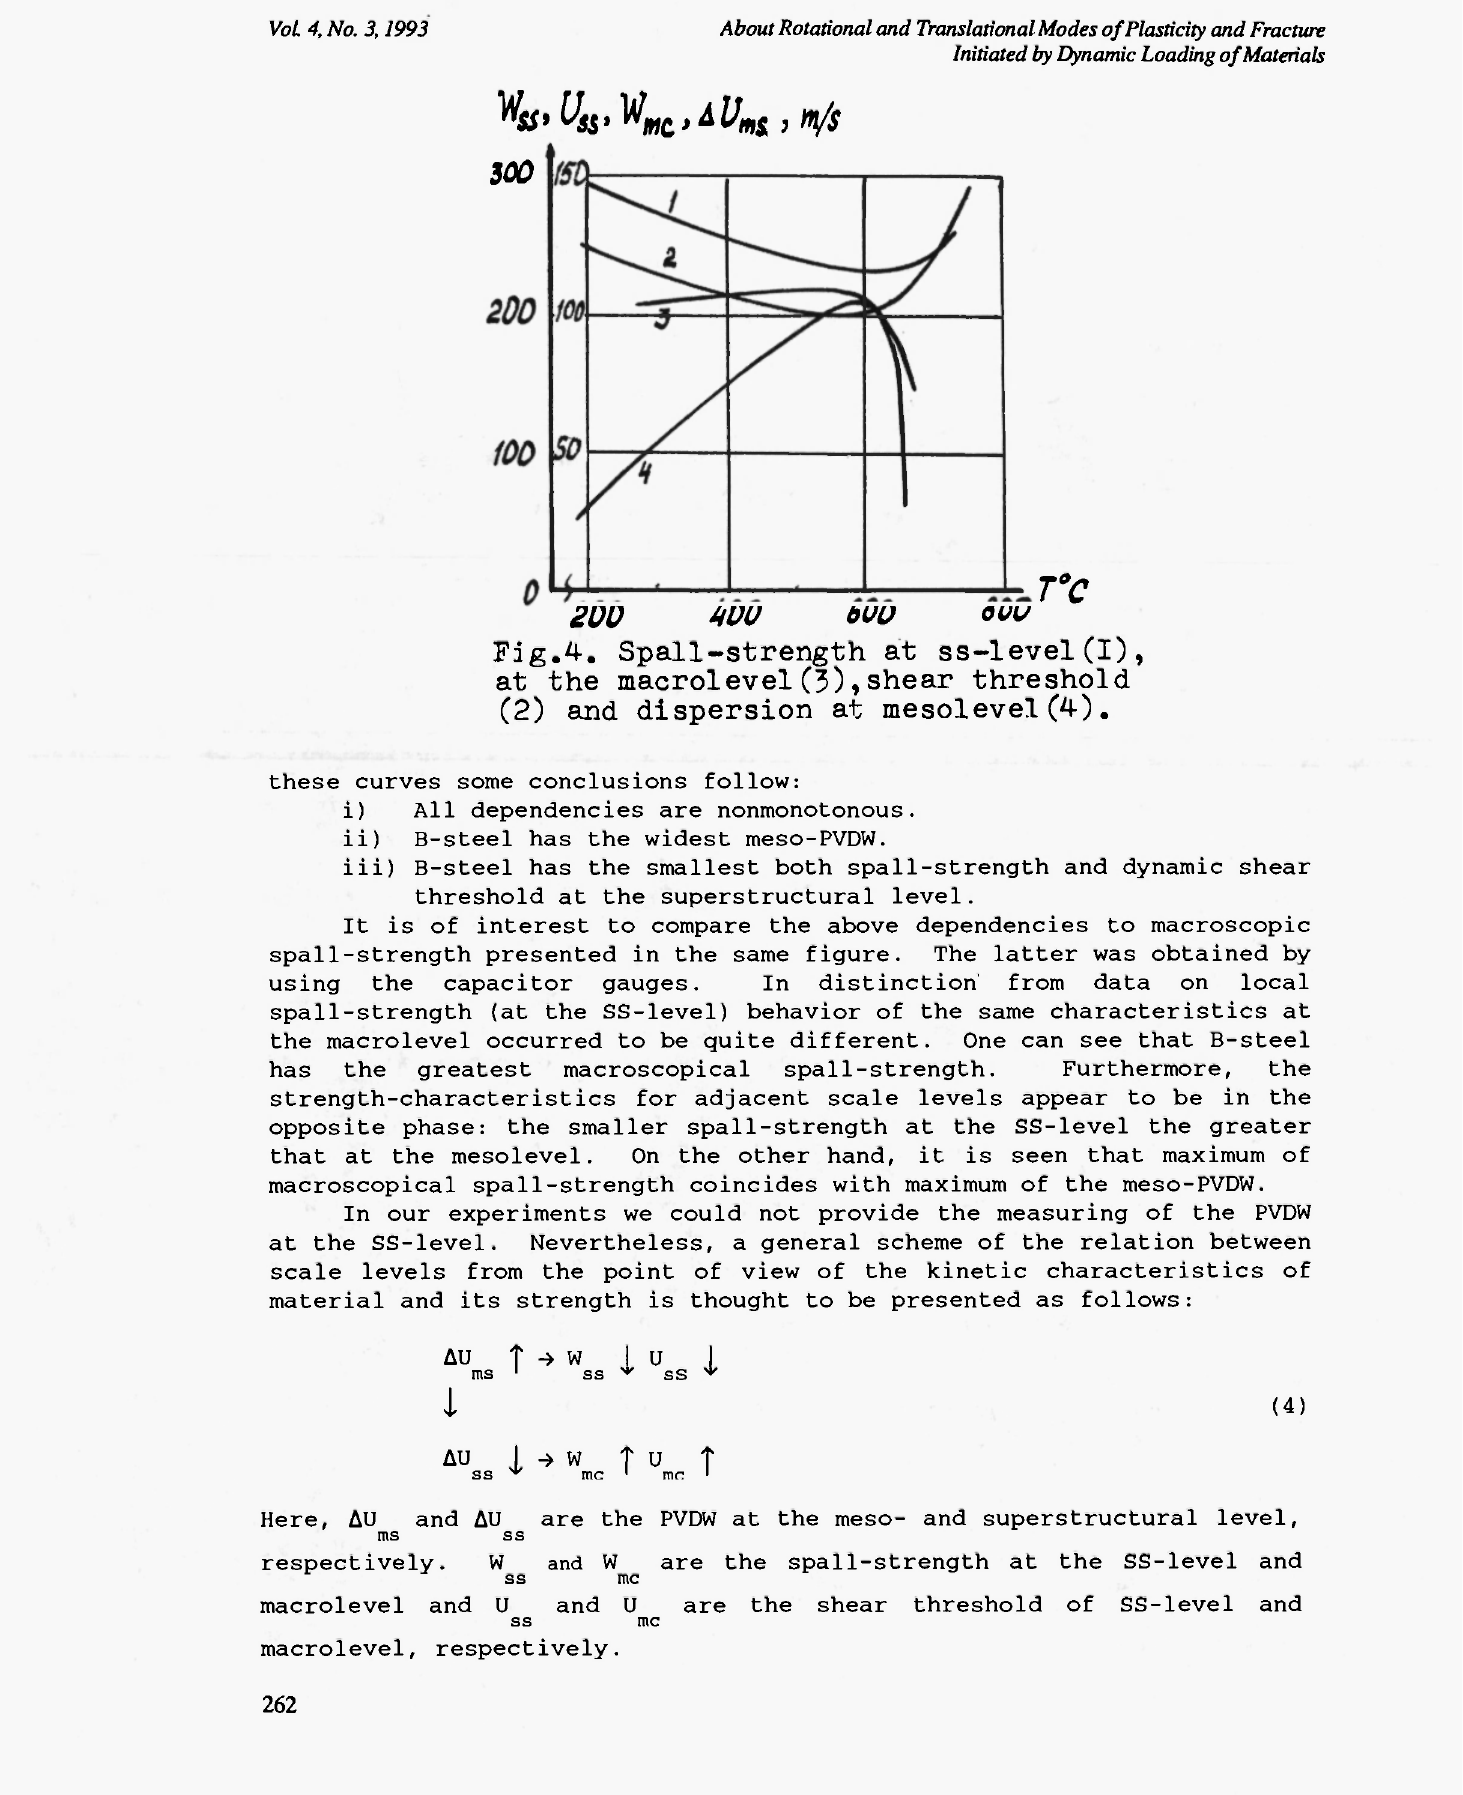
Fig.4. Spall-strength at ss-level(I), at the macrolevel (5),shear threshold (2) and dispersion at